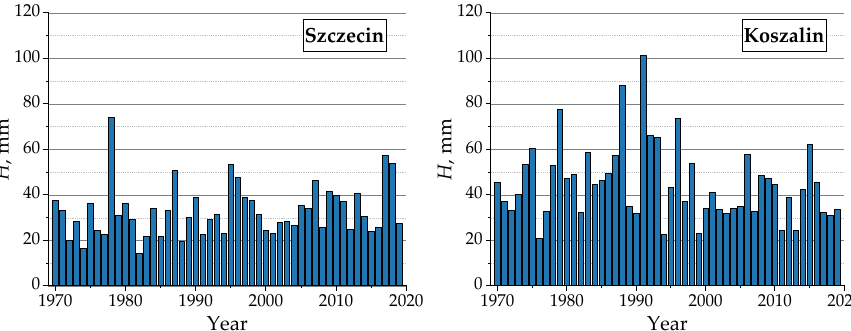
Figure 3. A set of the maximum daily precipitation amounts in Szczecin and Koszalin between 1970 and